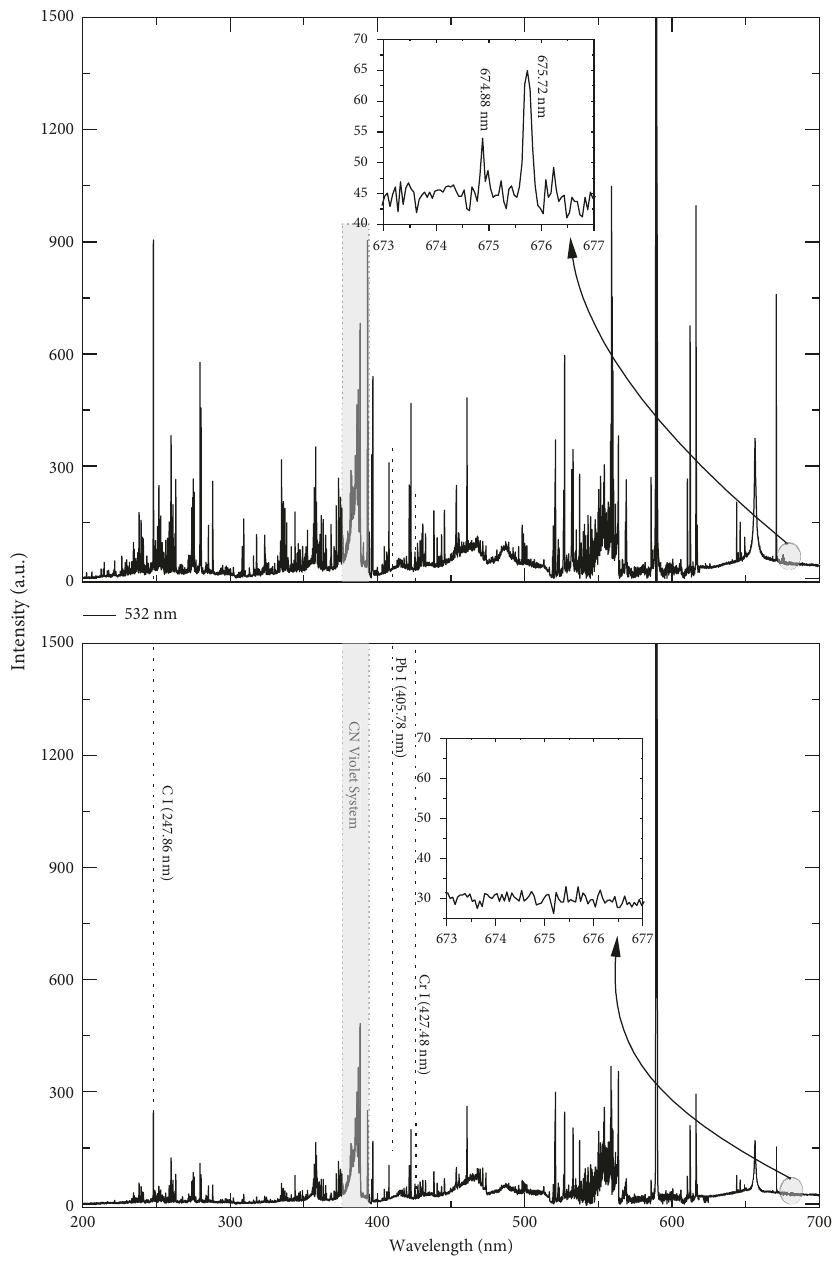
Figure 1: Comparison of emission spectra of Makerwal coal produced by irradiating laser beam of (a) 532 nm and (b) 1064 nm of Nd: YAG